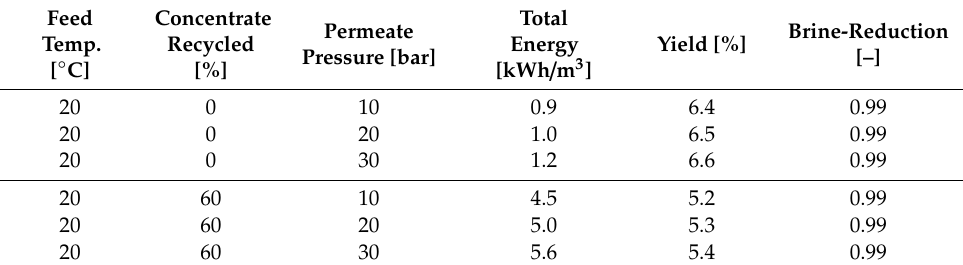
Table 7. Optimized results of SW30XHR-440i membrane at 20 ◦ C.